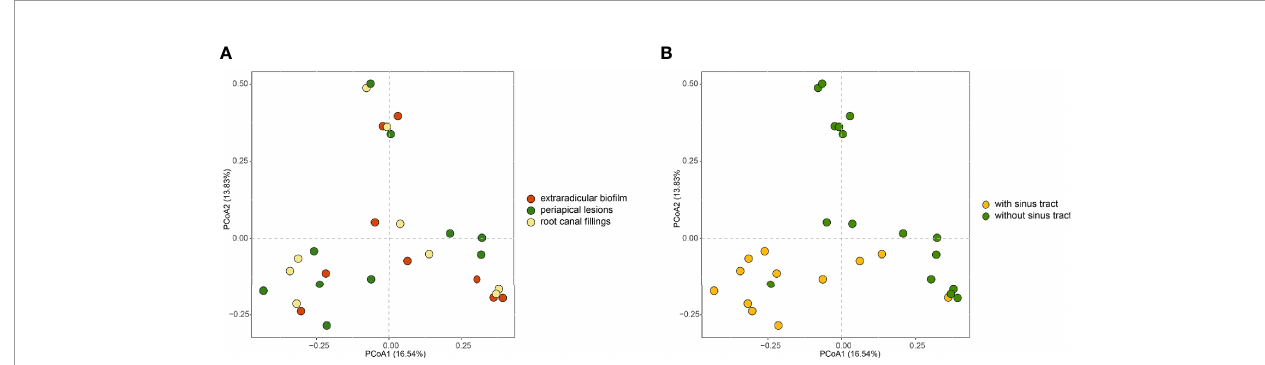
FIGURE 4 | PCoA plots of samples in intraradicular and extraradicular infections associated with persistent apical periodontitis. (A) PCoA plot of samples grouped based on the sampling sites; (B) PCoA plot of samples grouped based on the existence of sinus